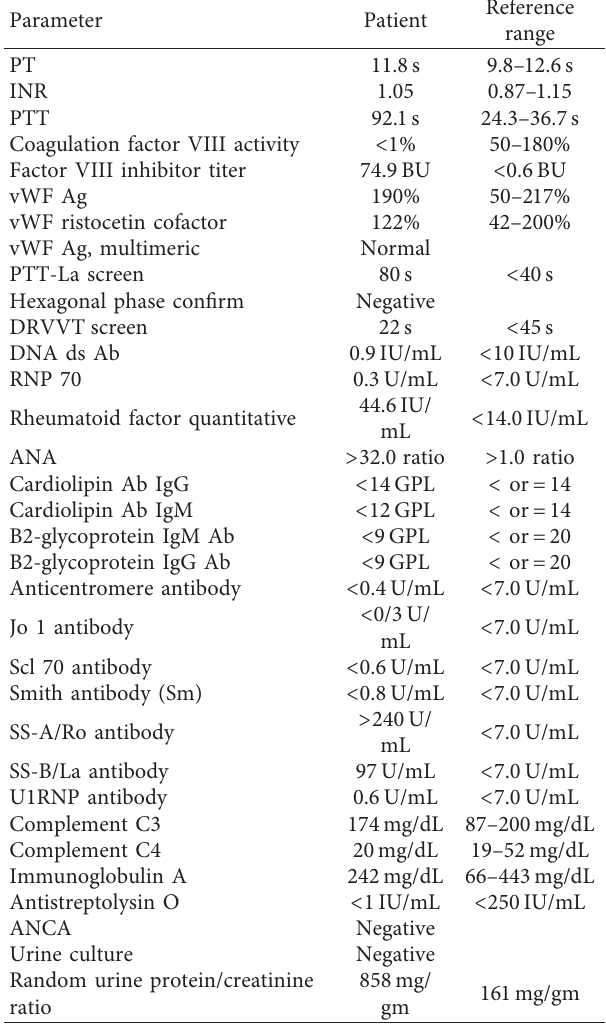
Table 1: Laboratory